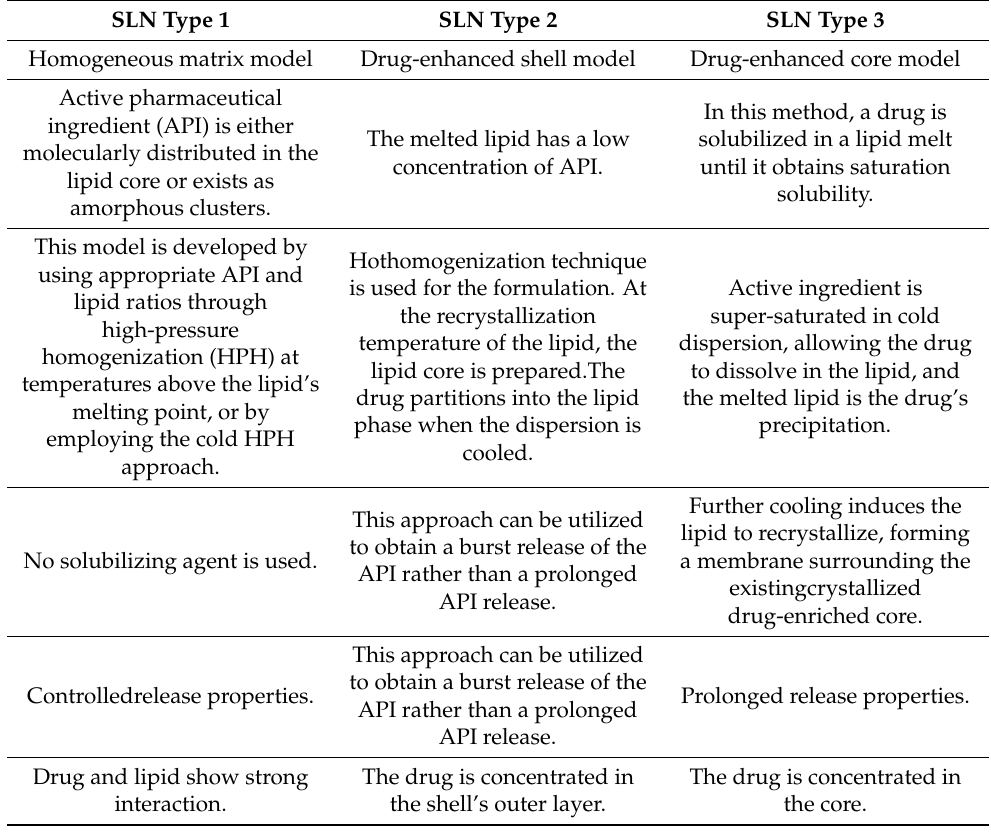
Table 1. Types of SLN